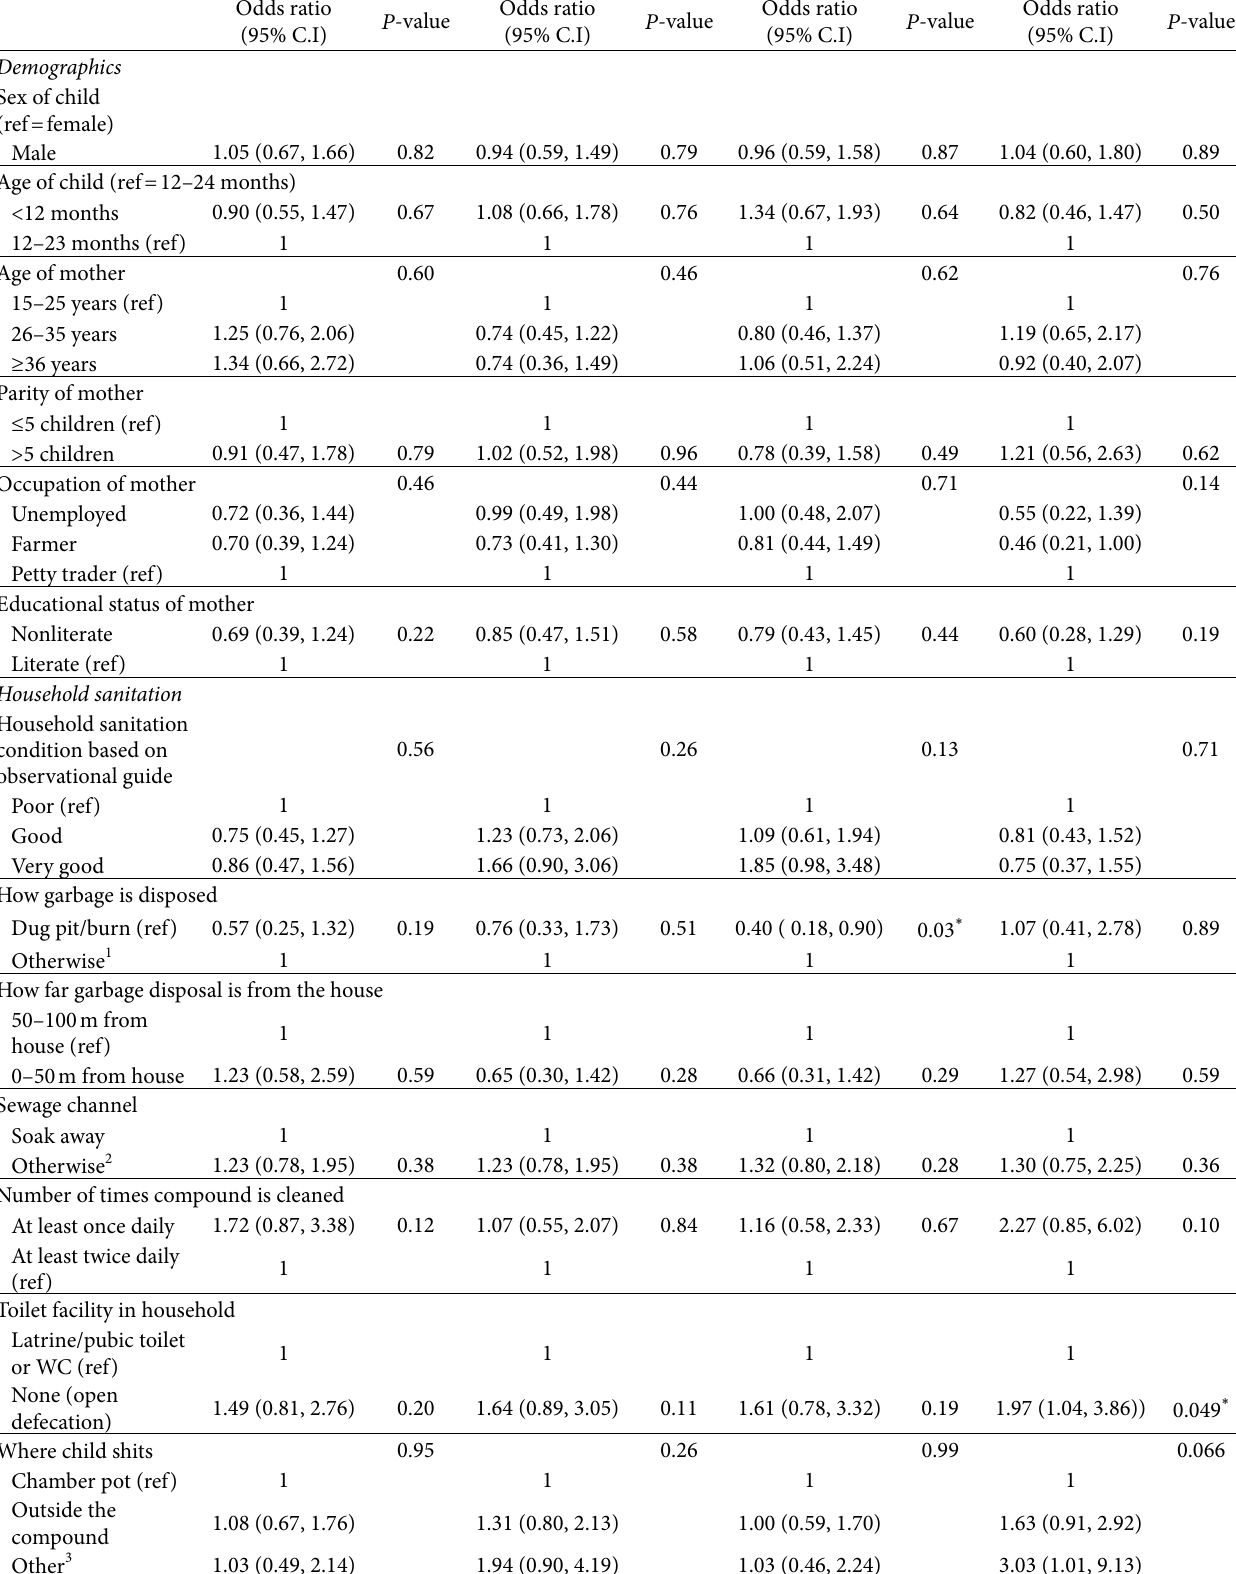
Table 5: Univariate determinants of diarrhoea and RTI morbidity and co-morbidity among the 6–23 months old children.